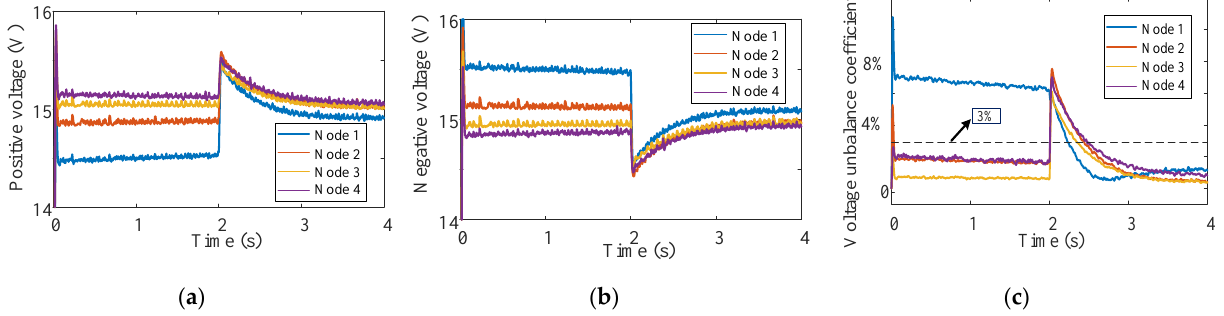
Figure 10. After adopting traditional droop control and adding consensus control, the changes in the ( a ) positive voltage ( b ) negative voltage and ( c ) voltage unbalanced coefficient in multi-node bipolar DC distribution network.